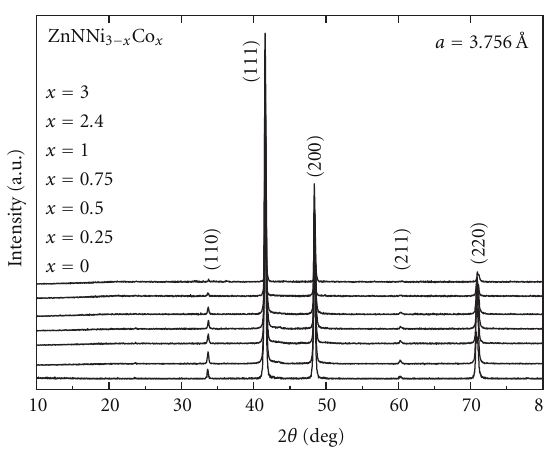
Figure 1: Powder X-ray di ff raction pattern for ZnNNi 3 − x Co x .